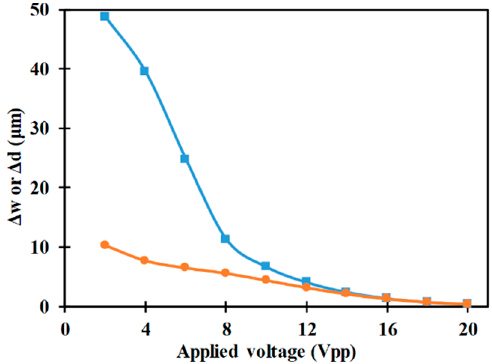
Figure 6. Variation of Δ w ( ■ ) and Δ d ( ● ) with applied voltage ( r p = 2 μ m, L e = 2000 μ m, L ch = 2200 μ m, W e = 80 μ m, Q m = 100 μ l/h, W ch = 200 μ m, H ch = 50 μ m). W e = 80 μ m, Q m = 100 μ l/h, W ch = 200 μ m, H ch = 50 μ